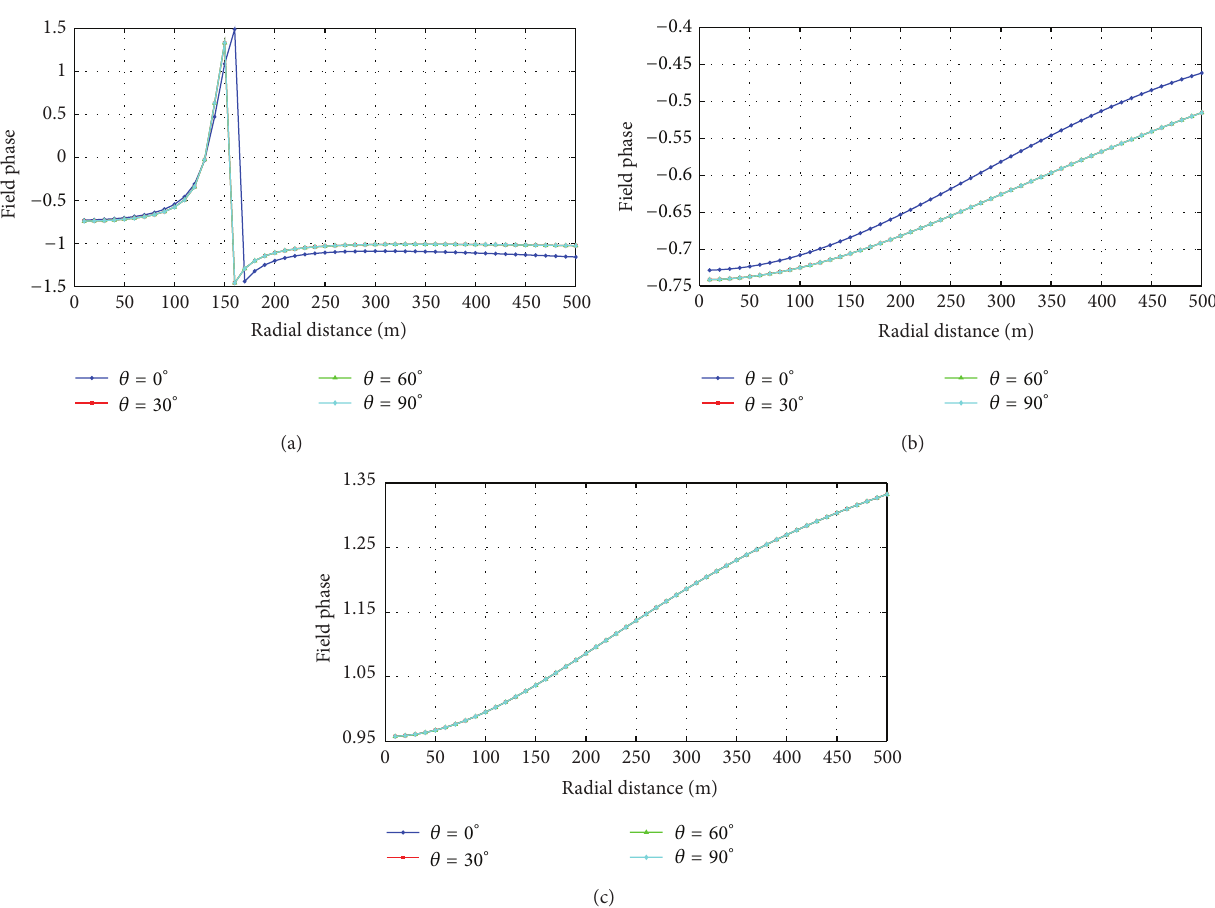
Figure 5: Curves of (a) the radial component of the electric field phase, (b) the tangential component of the electric field phase, and (c) the axial component of the electric field phase with the radial distance.